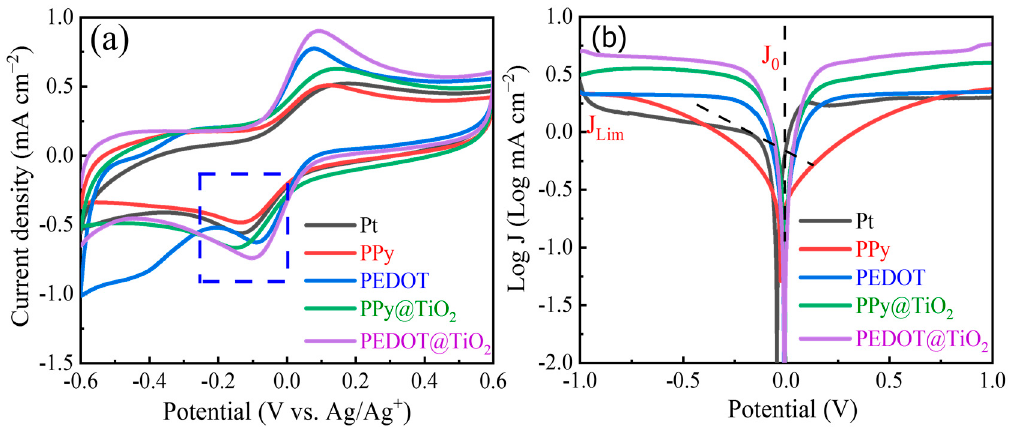
] 2(cid:3397)/3(cid:3397) and ( b ) Tafel polari- 3 2 , and PEDOT@TiO 2 CEs.